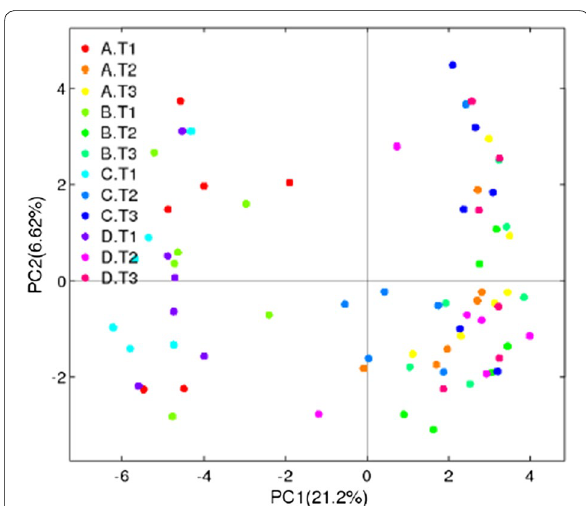
Fig. 3 Scatterplot from PCA of OTUs in each fecal sample. A, B, C and D mean fecal samples in diet 1, 2, 3, and 4 group, respectively. T1, T2, and T3 represent fecal samples collected on day 1, day 7, and day 14,